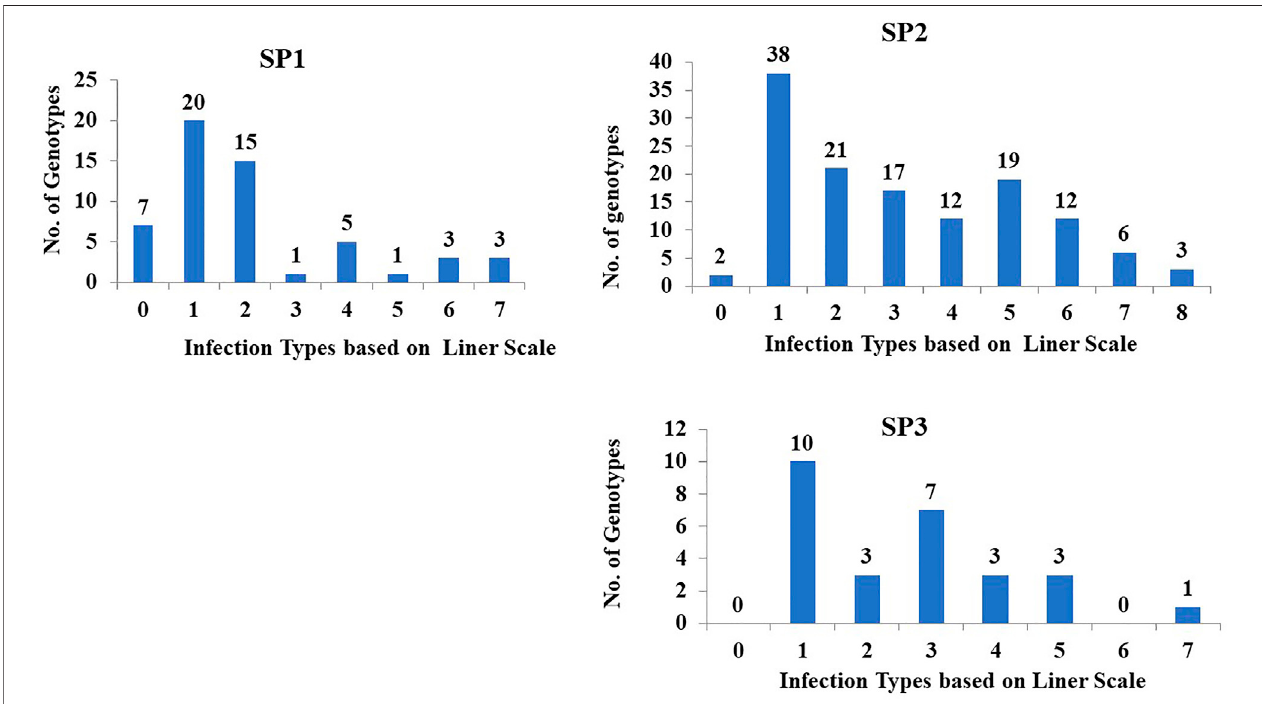
FIGURE 2 | The distribution of 212 tested genotypes with the most common stem rust race in Nebraska QFCSC over the three sub-populations. SP refer to subpopulation based on population structure analysis.